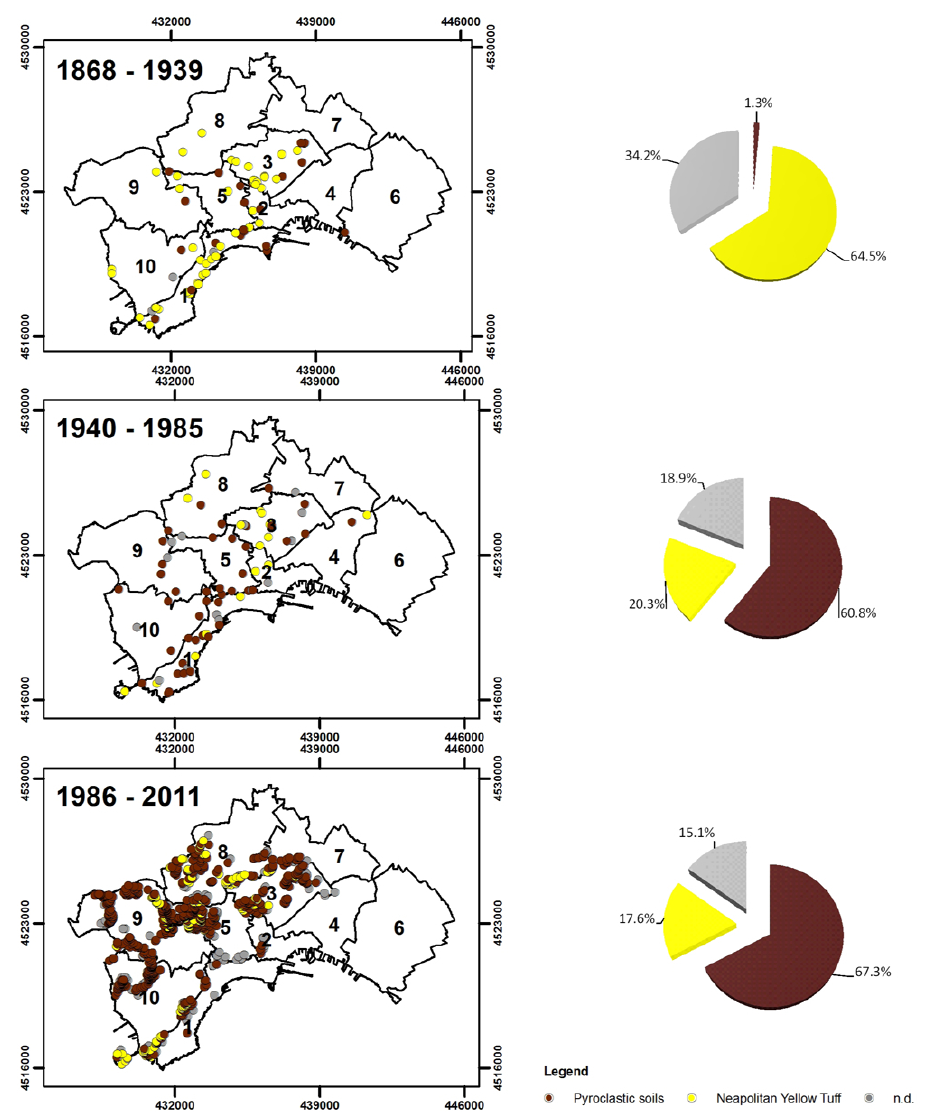
Fig. 8. Temporal distribution of the Naples’ landslides classified according to the lithologies involved (n.d. = unclassified).